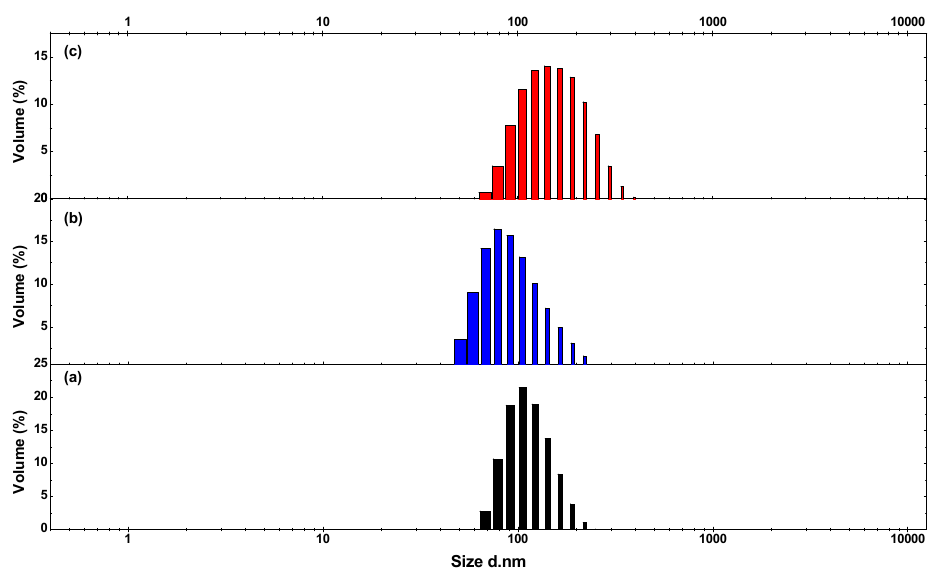
Figure 3. Particle size distribution of waterborne polyurethane: ( a ) WPU; ( b ) WPU-H; and ( c ) SCPU.